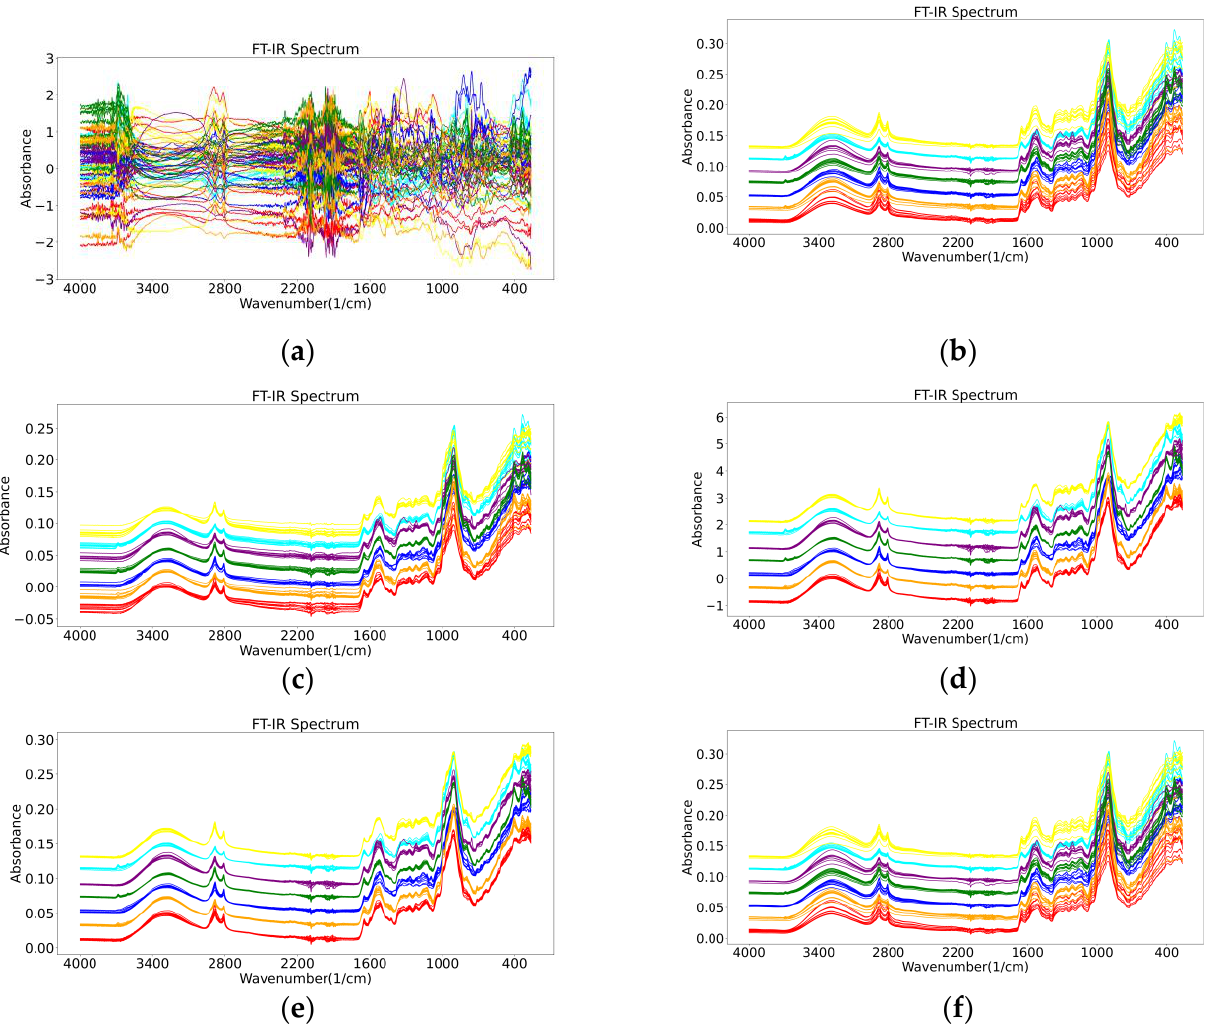
Figure 1. The results of six different pre-processing methods for FT-IR spectra of wild Gentiana genus : ( a ) normalization (Norm); ( b ) Savitzky–Golay (SG); ( c ) mean centralized (MC); ( d ) standard normalized variate (SNV); ( e ) multivariate scatter correction (MSC); ( f ) wavelet transform (WT).